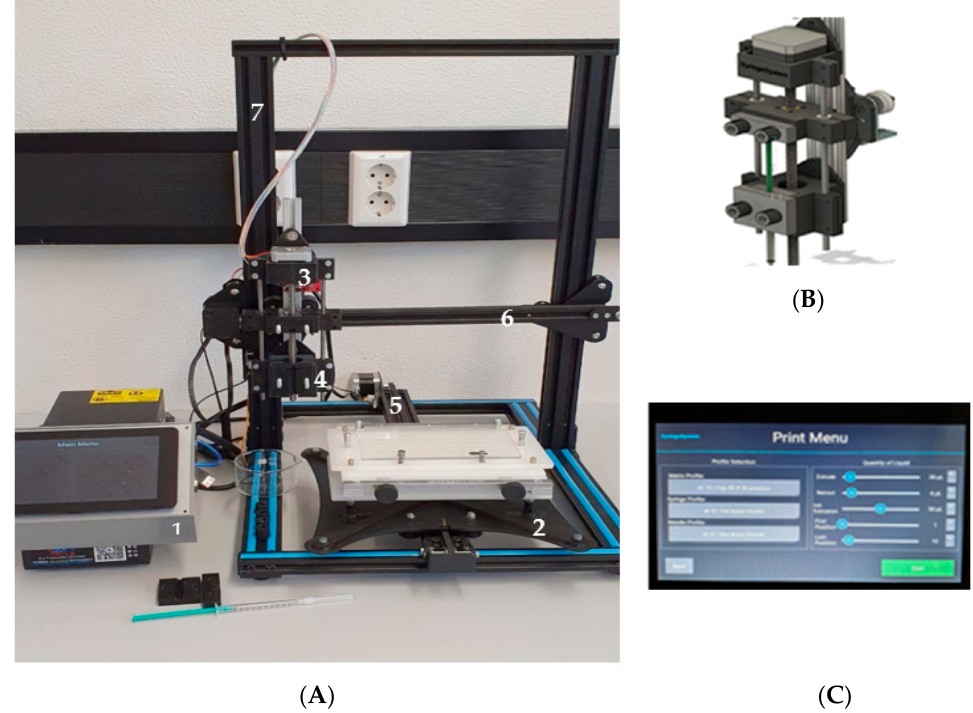
Figure 1. ( A ) Instrumentation of electronic liquid dispensing system (ELDS) consists of (1) control unit, (2) capsule board holder, (3) liquid dosing unit, (4) syringe holder, (5) capsule board travel rail, (6) dosing unit travel rail for x and y -axis, (7) dosing unit travel rail for z -axis; ( B ) liquid dosing unit; ( C ) control